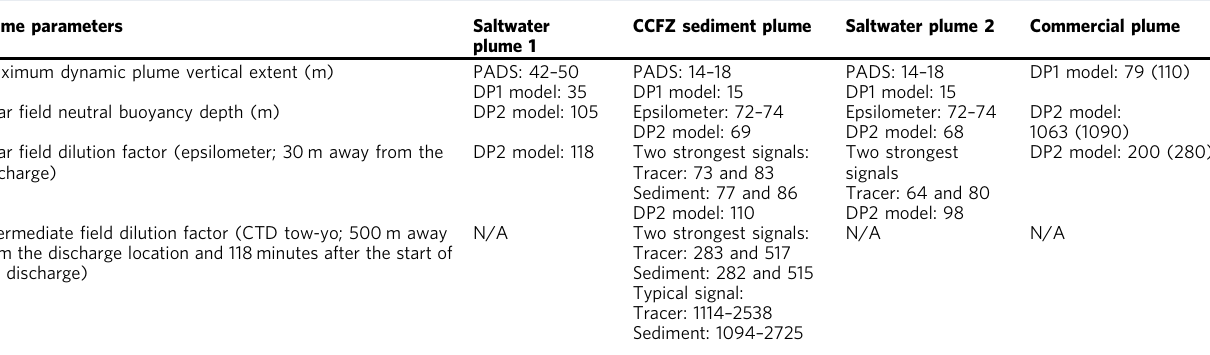
Table 2 Plume vertical extent and dilution factors measured during PLUMEX fi eld studies and predicted by the DP1 and DP2 dynamic plume